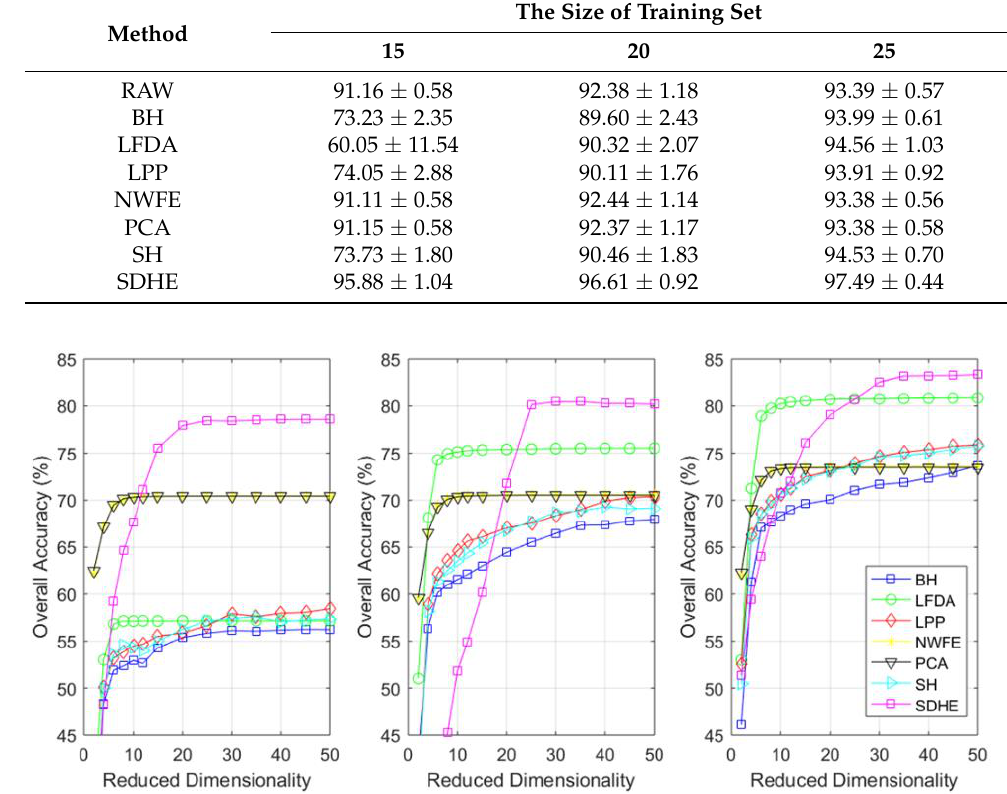
Figure 7. The OA (%) with the change of reduced dimensionality for Pavia University. ( a ) Indicates the training set of 15 samples per class, ( b ) indicates the training set of 20 samples per class, ( c ) indicates the training set of 25 samples per class.